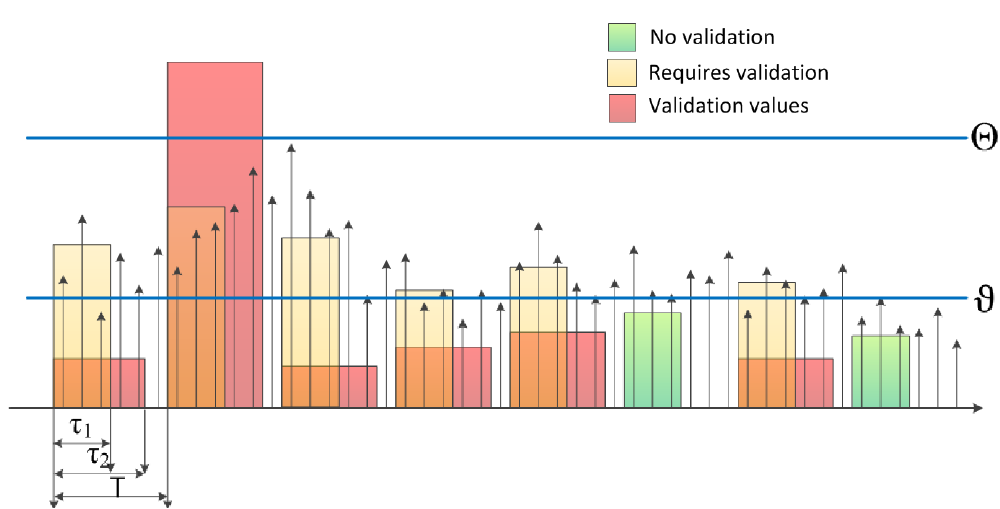
Figure 3. Operation of the Block-wise Autocovariance-based Algorithm With Validation (BACV). Narrow rectangles of width τ represent segments where preliminary sampling 1 and processing is performed; yellow and green rectangles represent segments where the computed autocovariance is higher and lower than the preliminary threshold ϑ , respectively. threshold Θ to produce the detection